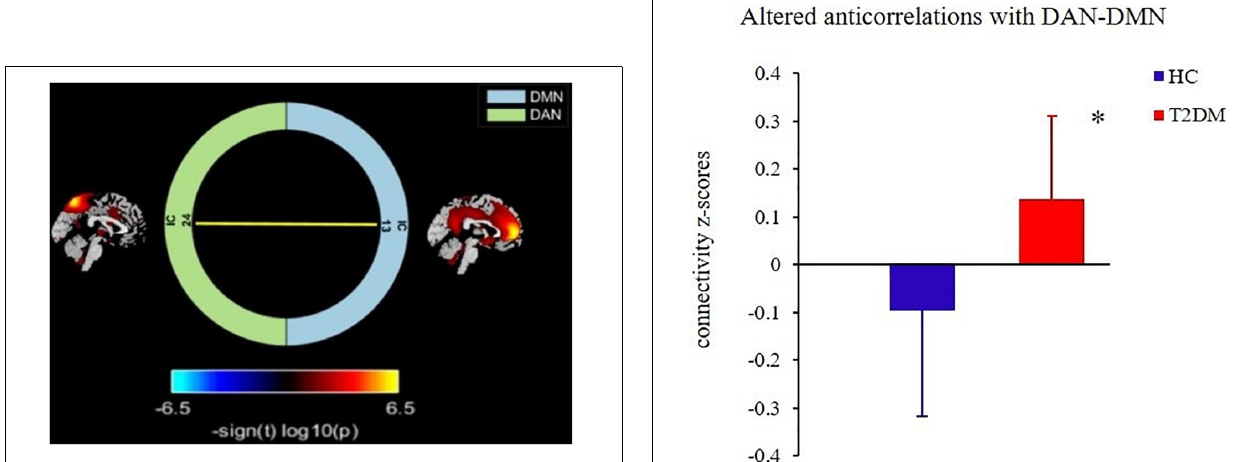
FIGURE 4 | The groups differed significantly in their average connectivity between IC24 and IC13 in the DAN and DMN. The horizontal axis represents the groups, the ordinate axis represents average functional connectivity, and the error bars represent standard deviations, ∗ P <